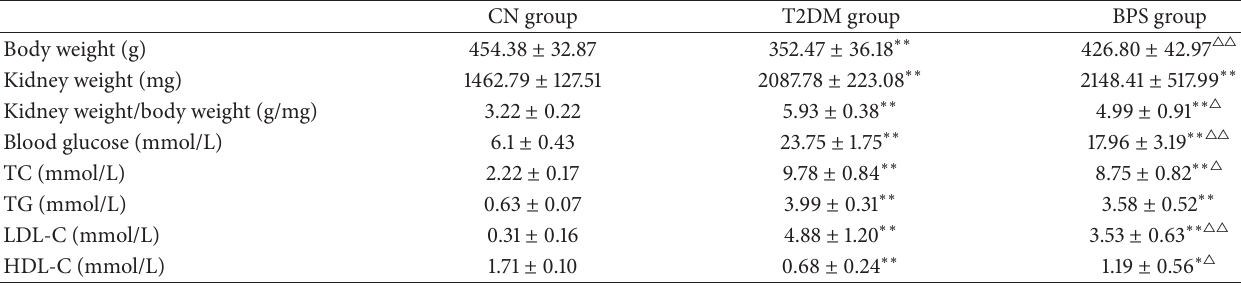
Figure 1: Body weight (a), body weight after 12 weeks (b), kidney weight (c), kidney weight/body weight (d), TC (e), TG (f), LDL-C (g), HDL-C (h), and blood glucose (i) in CN group rats, T2DM group rats, and BPS group rats. As line graph and bar graph, data are mean ± SEM of 6 rats. ∗ 𝑃 < 0.05 and ∗∗ 𝑃 < 0.01 T2DM group and BPS group versus CN group rats and 󳵻 𝑃 < 0.05 and 󳵻󳵻 𝑃 < 0.01 BPS group versus T2DM group. Table 3: Body weight, kidney weight, kidney weight/body weight, blood glucose, and blood lipid profile (TC, TG, HDL, and LDL) of rats in experiment ( 𝑛 = 6 , 𝑋 ± 𝑆